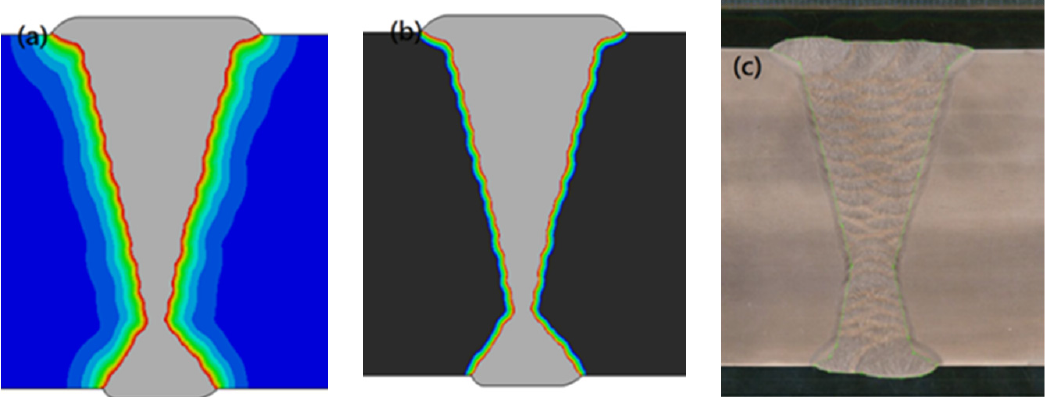
Figure 8. Comparison of Simulation Results and Experimental Results of Welded Joint of Heavy Plate: ( a ) Weld pool shape; ( b ) Morphology of HAZ; ( c ) Experimental results [20].